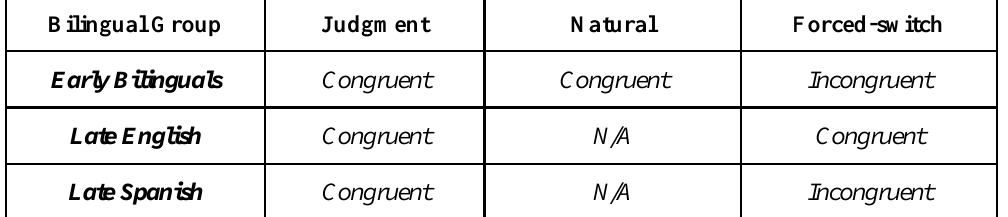
Table 13. Congruency preference per bilingual group per task Bilingual